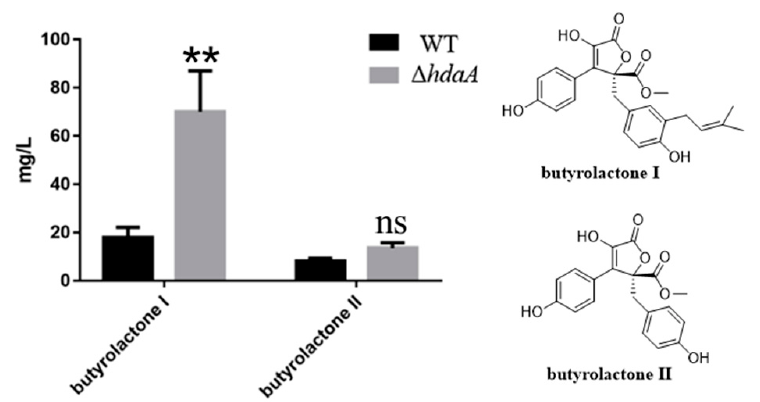
Figure 2. Growth of wild-type (WT) A. terreus RA2905 and the ∆ hdaA strain on PDA plates.